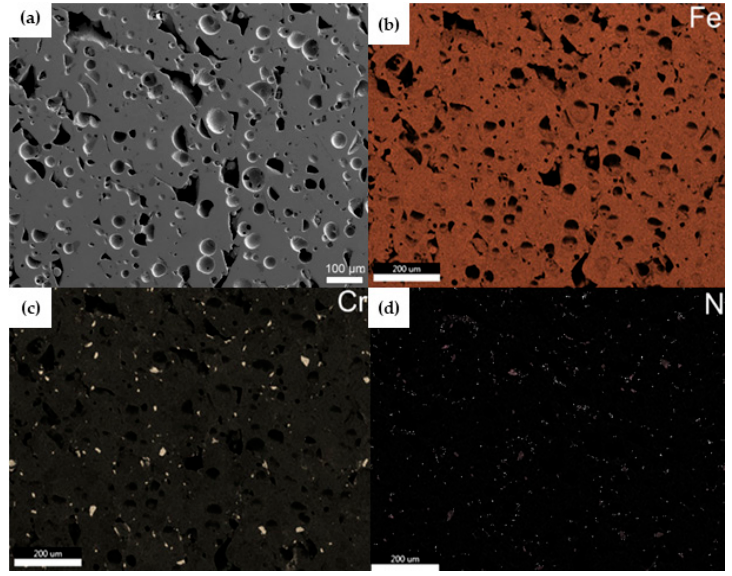
Figure 7. ( a ) Scanning electron microscopy (SEM) images of the 5% CrN x sample, and the corresponding elemental maps for ( b ) Fe, ( c ) Cr, and ( d ) N [50].